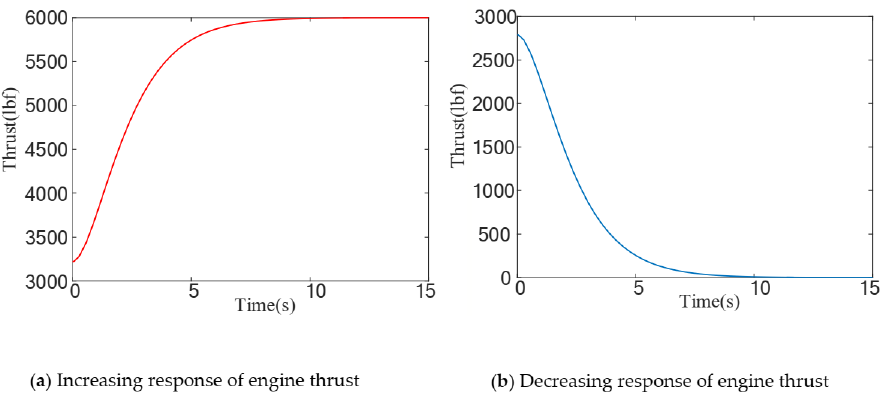
Figure 2. The engine response under the flight condition of Mach 0.8 and 30,000